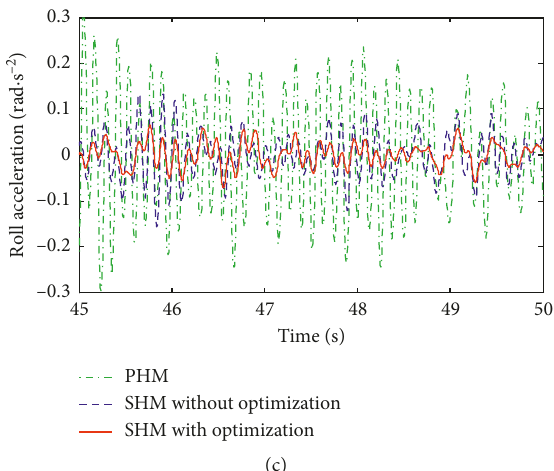
Figure 9: Results of the acceleration responses on the deformable terrain. (a) Vertical driver’s seat. (b) Cab’s pitch angle. (c) Cab’s roll angle.